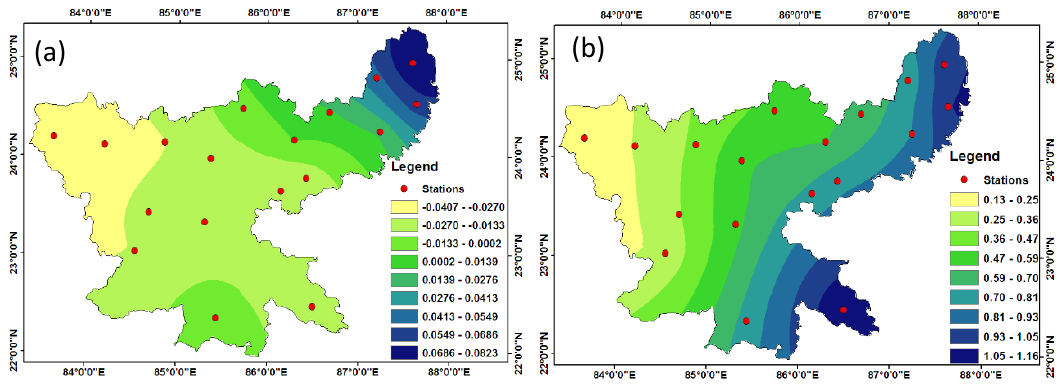
Figure 9. Spatial distribution of temporal change in Pre monsoon rainfall during 1901 to 2002 ( a ) and from 1952 to 2002 ( b ).